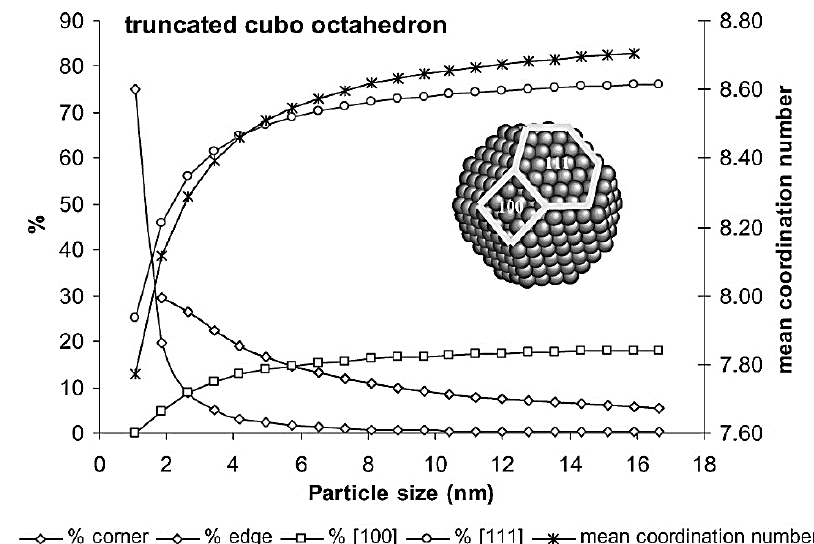
Figure 13. The distribution of the different types of sites and mean coordination number of surface atoms for truncated cuboctahedral particles. Reproduced with permission from Ref. [128]. Copyright© 2010, Taylor and Francis.